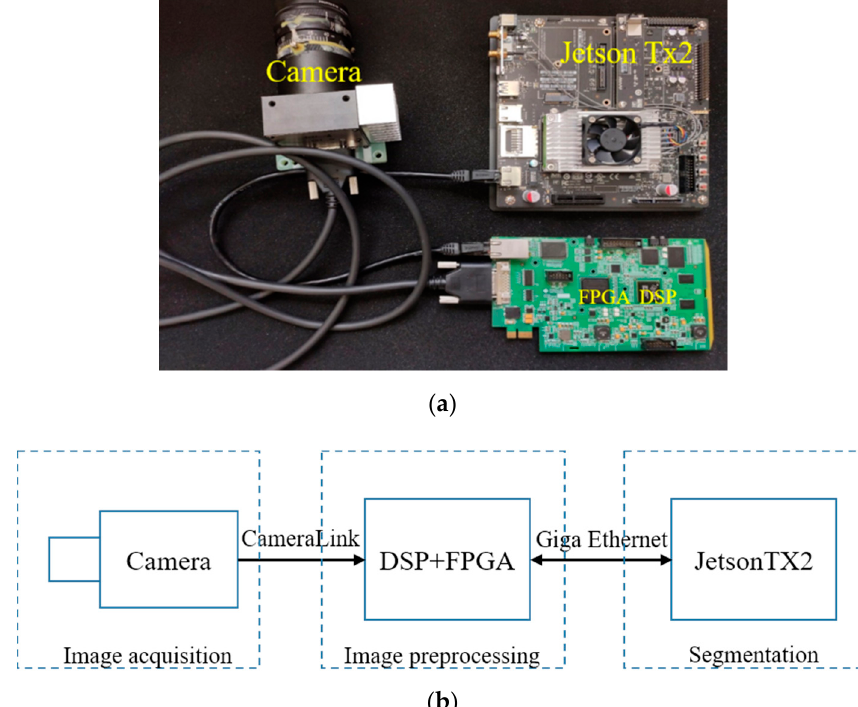
Figure 5. ( a ) The hardware diagram. ( b ) The principle block diagram.